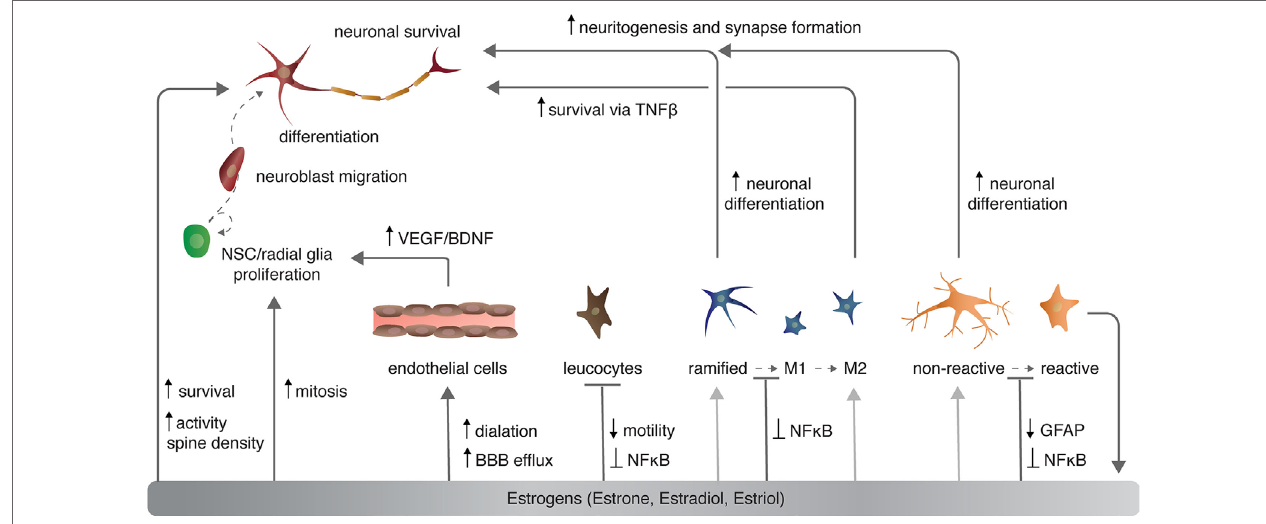
FiGURe 2 | The effects of estrogen on various cell types in the central nervous system. Light gray arrows indicate that estrogens have an effect on neurons via the given cell type to which the arrow